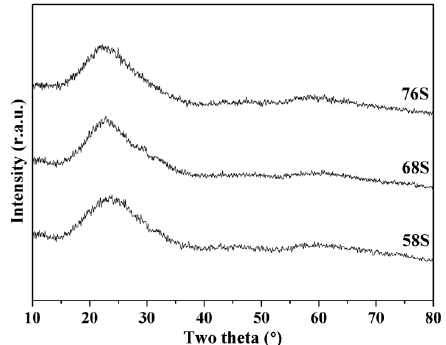
Figure 1. X-ray diffraction (XRD) patterns of spray dried 58S, 68S and 76S bioactive glass (BG)